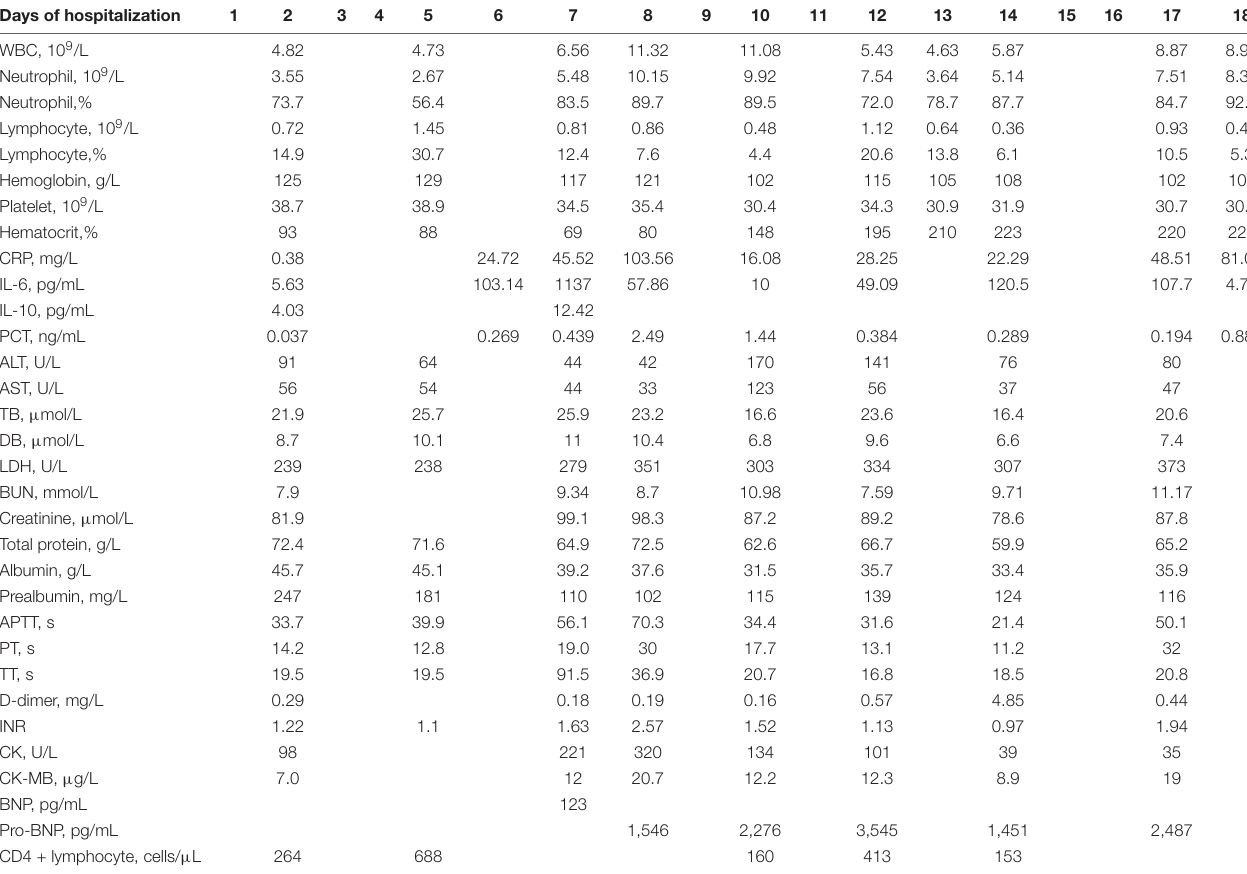
TABLE 1 | Timeline of changes in laboratory